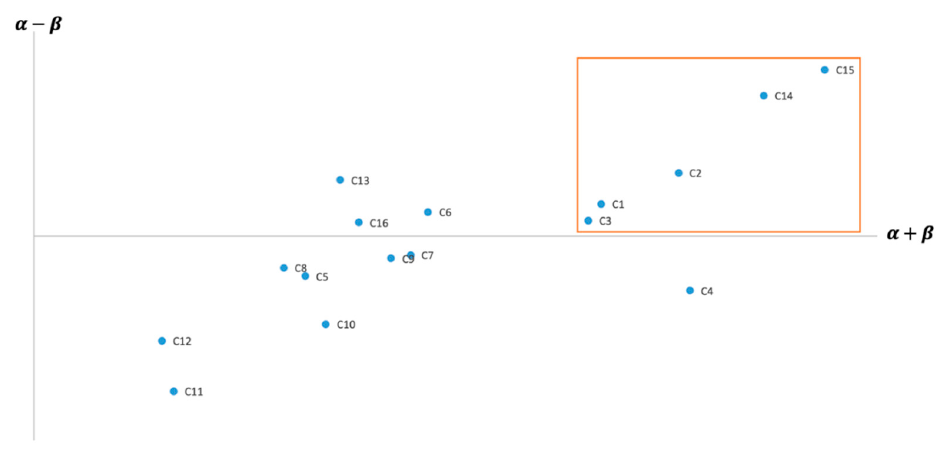
Figure 2. Cause–effect diagram for criteria.